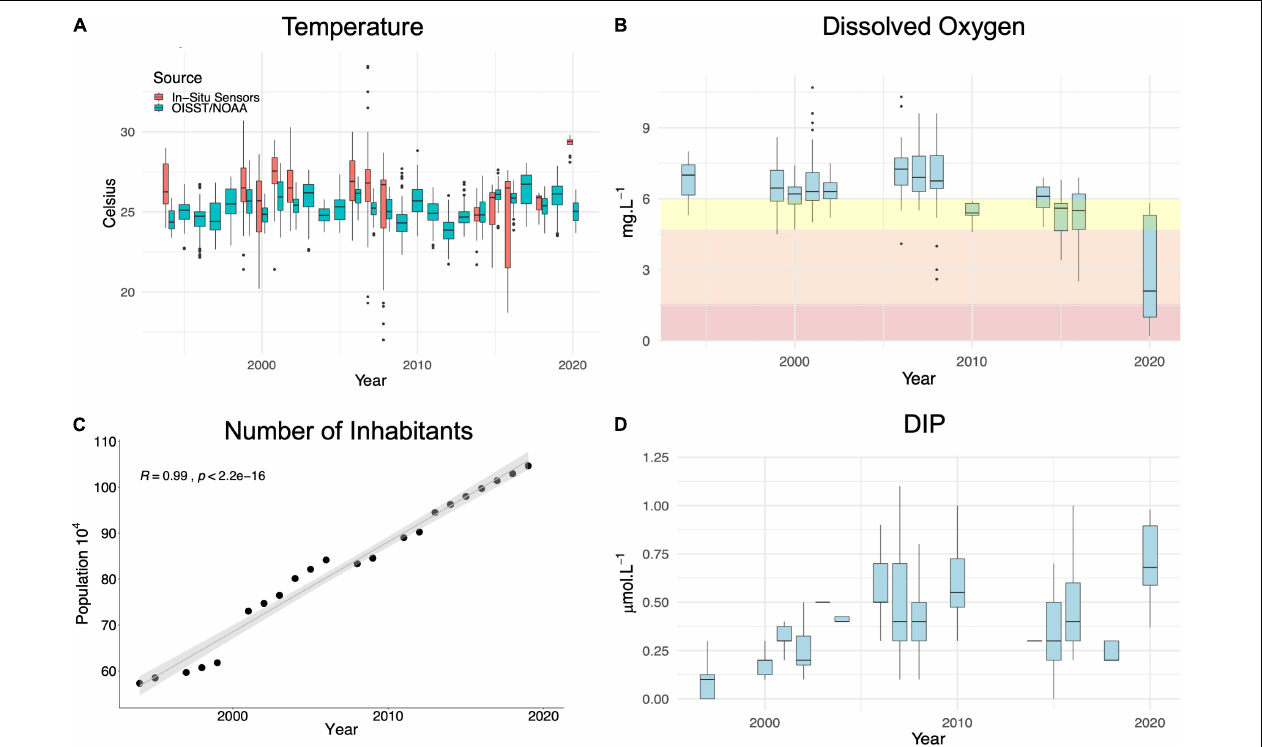
FIGURE 3 | Interannual variability (1994–2020) of (A) temperature ( in situ and OISST), (B) dissolved oxygen (DO), (C) number of inhabitants, and (D) dissolved inorganic phosphorus (DIP) in the Bay of Santa Catarina Island during the summer seasons. The number of human inhabitants per year (C) was calculated considering all nine municipalities around the bay. In the DO graph, red shows hypoxia (DO < 2.0 mg L − 1 , Breitburg et al., 2018), orange indicates biological stress conditions (DO < 5.0 mg L − 1 , Devlin et al., 2011) and yellow indicates a warning boundary considering the benthic and phytoplanktonic richness losses found in this study.